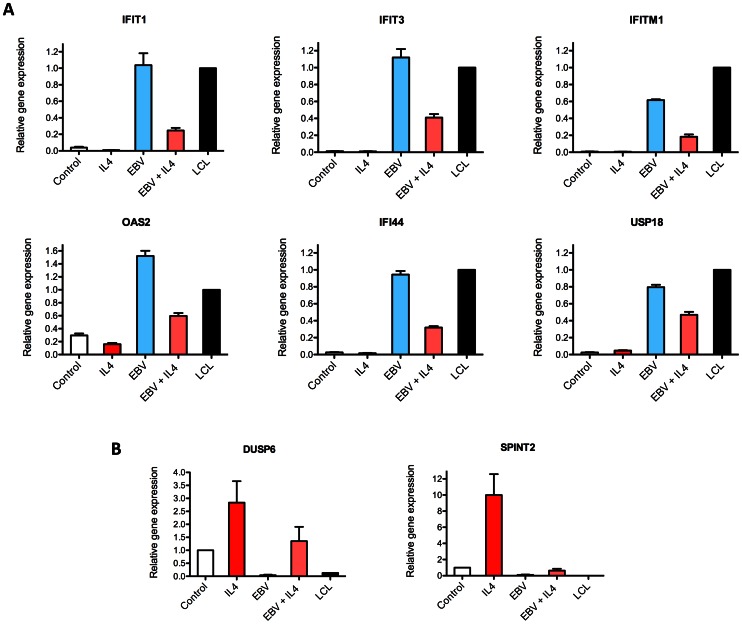
Effect of IL4 on transcription in B cells.Quantitative RT-qPCR assays for selected cellular gene transcripts in peripheral blood B cell cultures in normal medium or containing IL-4 (assayed at 6 hrs), or infected with EBV in normal medium or containing IL-4 (assayed at 7 days). The results are expressed as mean ± SEM of three replicate experiments using B cells from different donors. An established LCL was used as a reference for all assays, and all values are shown relative to LCL transcript expression = 1, except for SPINT2 and DUSP6 whose expression in the reference LCL was extremely low (ddCt<12) and where expression is shown relative to control B cell cultures. The six cellular genes shown in (A) were reported by Elo et al
[35] to be down-regulated by IL4 in T cells, whilst the 2 genes shown in (B) were reported to be up-regulated by IL-4 in T cells.